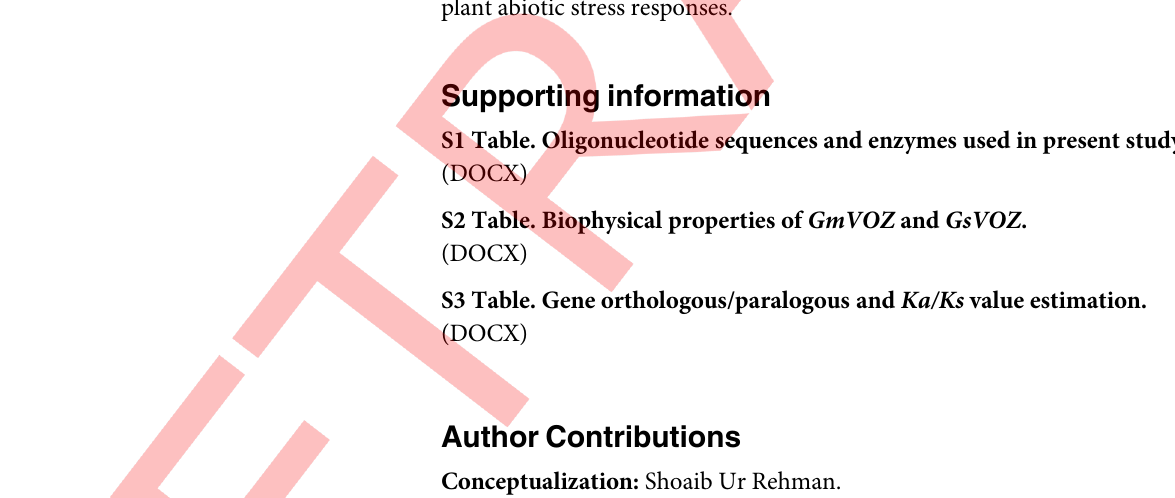
S1 Table. Oligonucleotide sequences and enzymes used in present study. S2 Table. Biophysical properties of GmVOZ and GsVOZ . S3 Table. Gene orthologous/paralogous and Ka/Ks value